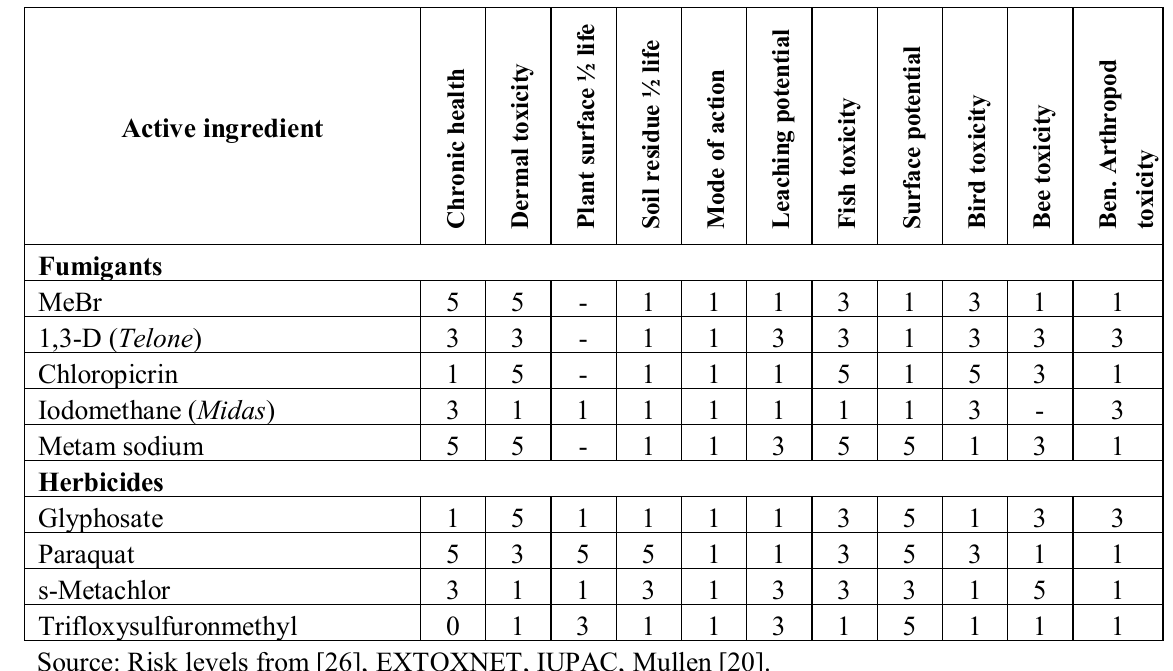
Table 4. Methyl bromide and alternative fumigant risk